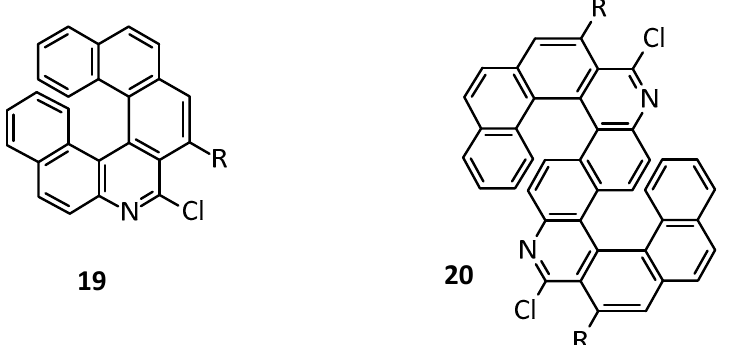
Figure 3. Azahelicenes obtained by sequential intramolecular Au-catalyzed diyne or tetrayne hy- droarylation.